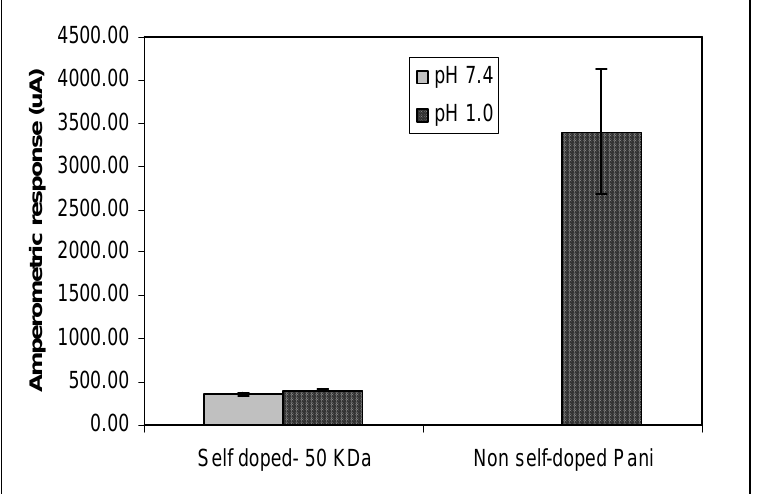
Figure 6 . Amperometric responses of ITO substrates coated with non-self doped Pani and 50 KDa self doped Pani in two pH controlled